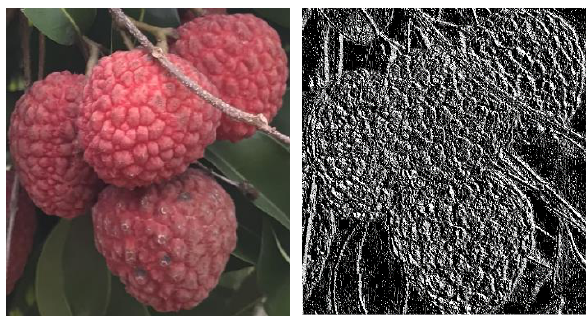
Figure 10. Local binary pattern (LBP) operator representation of a lychee image.